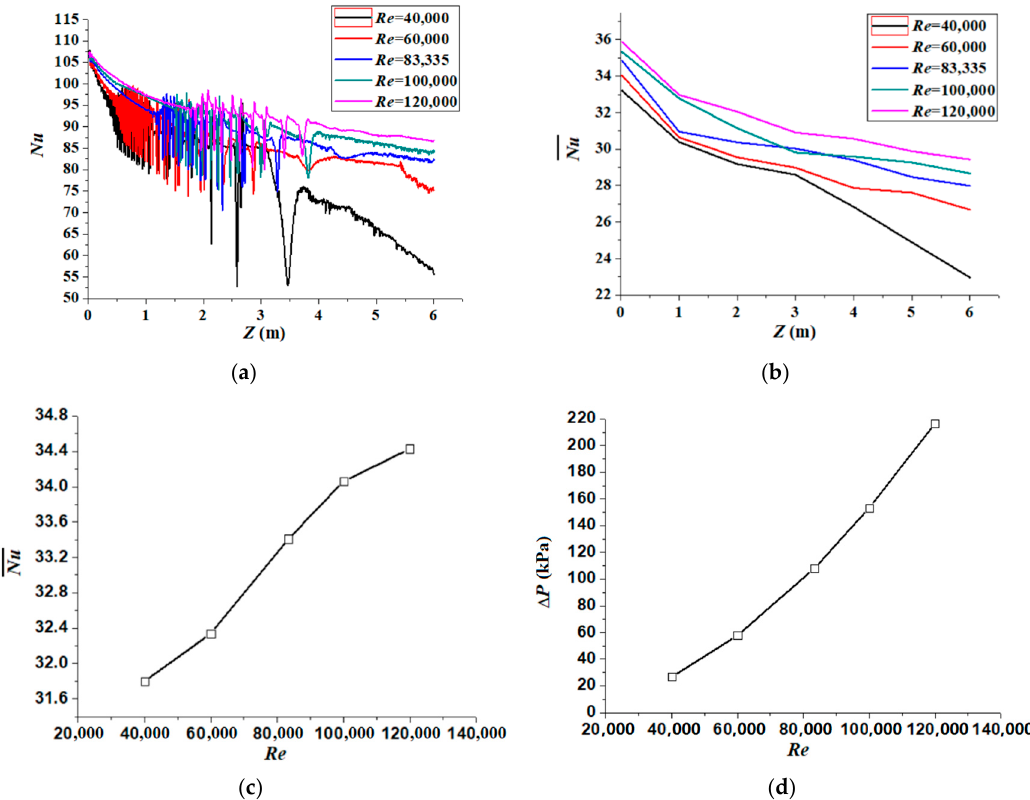
Figure 13. Nu and Δ p for different Re values and α = 90°: ( a ) local Nu on Line 2; ( b ) peripherally averaged Nu along the Figure 13. Nu and ∆ p for different Re values and α = 90 ◦ : ( a ) local Nu on Line 2; ( b ) peripherally averaged Nu along the tube; ( c ) average Nu of the whole tube; ( d ) pressure loss. tube; ( c ) average Nu of the whole tube; ( d ) pressure